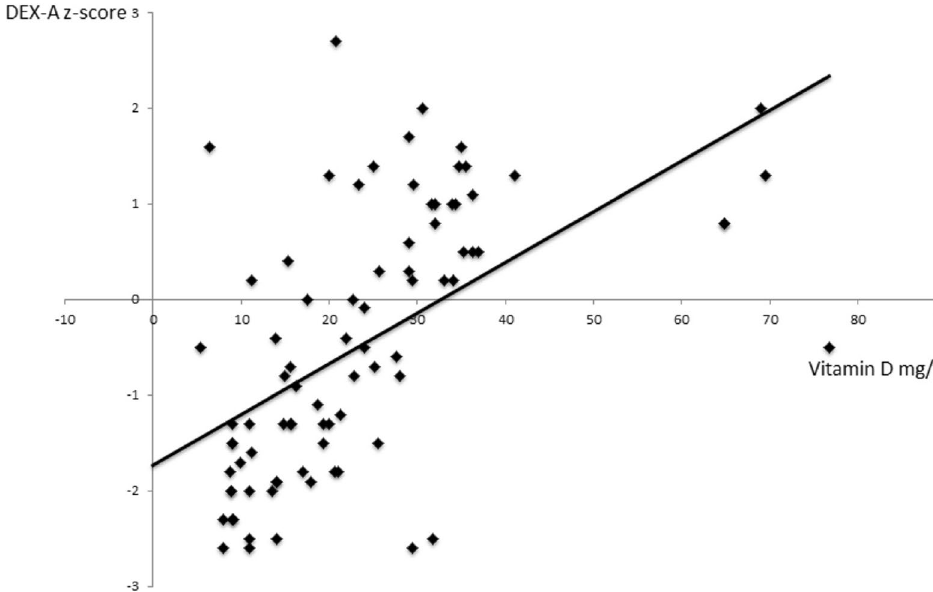
Figure 1. Correlation between vitamin D serum levels and bone mineral density values.